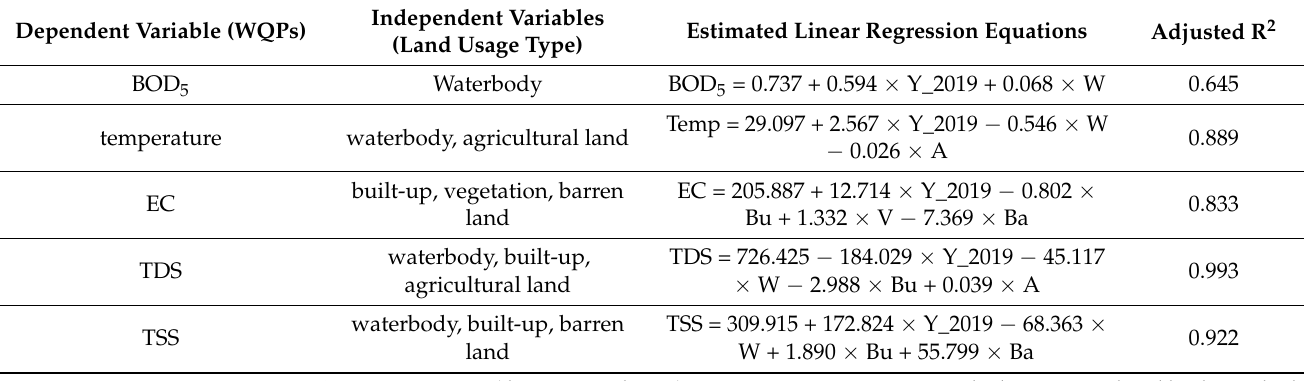
Table 8. Linear regression models of LULC types on the